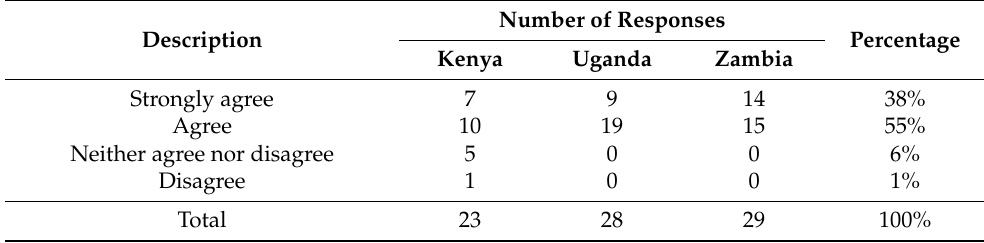
Table 3. Perceptions on the STDM ability to influence changes in policy and institutional